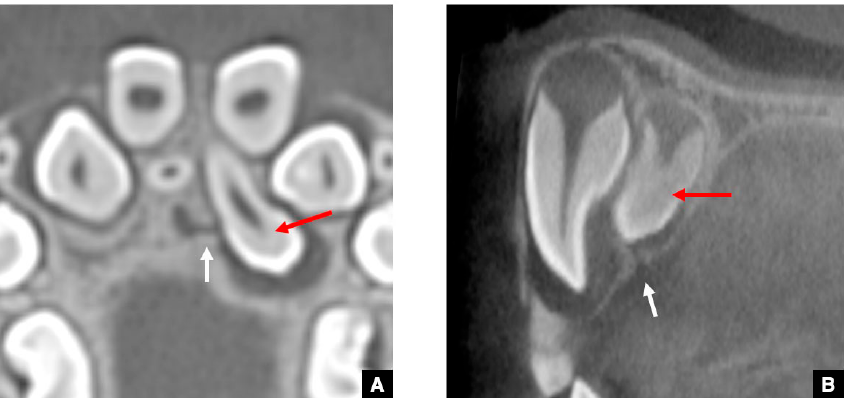
Figure 5. CBCT images of GTs in mesiodens. ( A ) The GT (arrow) of the inverted mesiodens (red arrow) is derived from the incisive canal on a CBCT axial image. The major connecting area of the GTs in inverted mesiodens is the cervical area. ( B ) The GT (arrow) of the mesiodens (red arrow) with normal eruption is derived from the alveolar crest on a CBCT sagittal image. The connecting area of the major GTs in the mesiodens with normal eruption is the crown area.